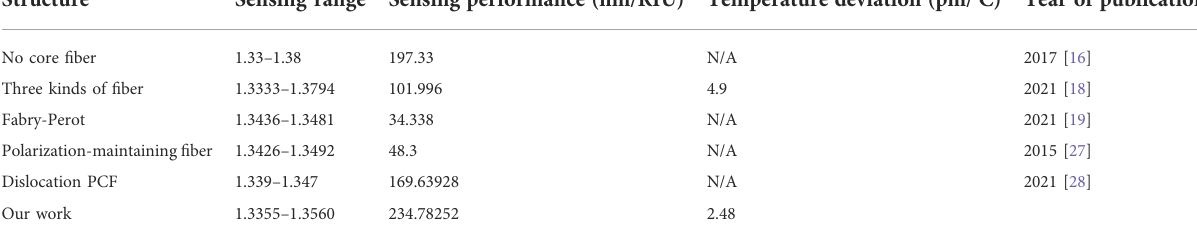
TABLE 1 Compared with the experimental data of optical fi ber sensor published in recent years.